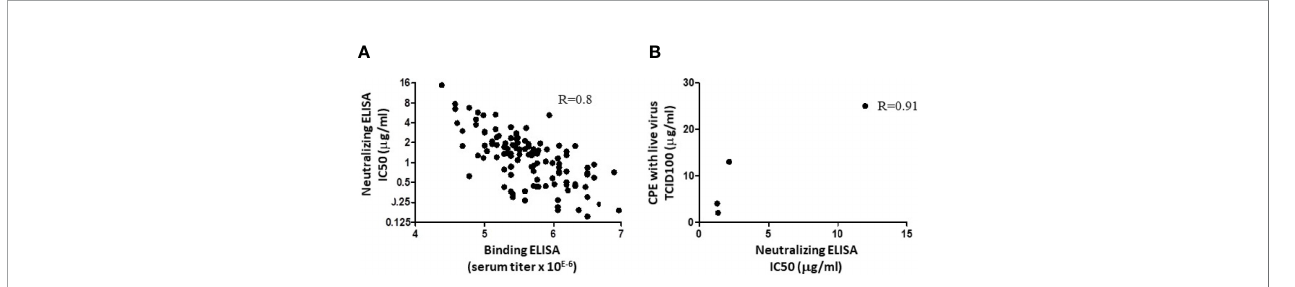
FIGURE 1 | Correlation between binding, neutralizing ELISA, and CPE assay. (A) A series of 117 individual hyperimmune serum samples were assessed in parallel in an RBD binding ELISA and in a Spike/ACE-2 interaction ELISA. Linear correlation was observed with R= 0.8. Dots represent data from duplicate measurements in a single experiment. (B) Four R&D batches of swine anti-RBD polyclonal IgG were produced, with different binding activities against SARS-CoV-2 Spike (23). These samples were evaluated in parallel in the Spike/ACE-2 neutralization assay, as in A, and by CPE. IC50 in ELISA and CPE, expressed in tissue culture infectious dose (TCID 100 ), are from single experiments and have been plotted to evaluate the correlation. The R value after linear extrapolation was